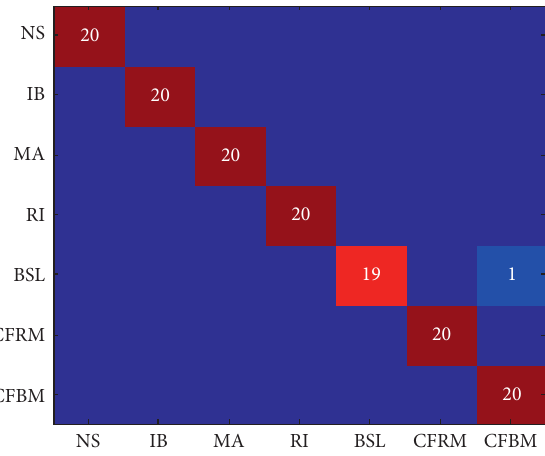
Figure 9: Classification result by the method in this